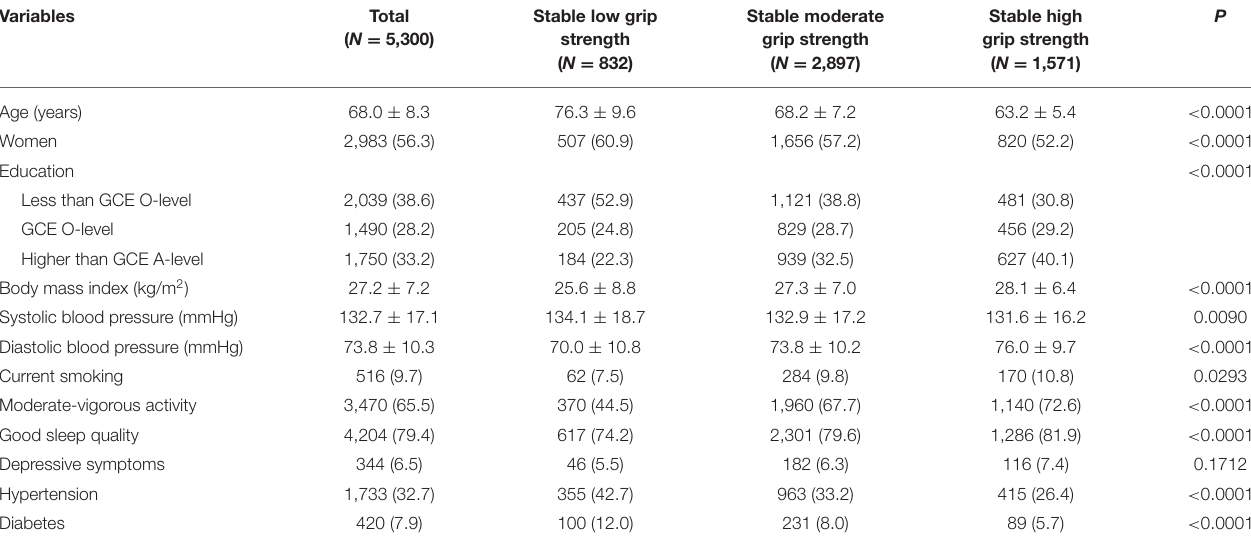
TABLE 1 | Baseline characteristics of the participants based on trajectories of grip strength. Variables